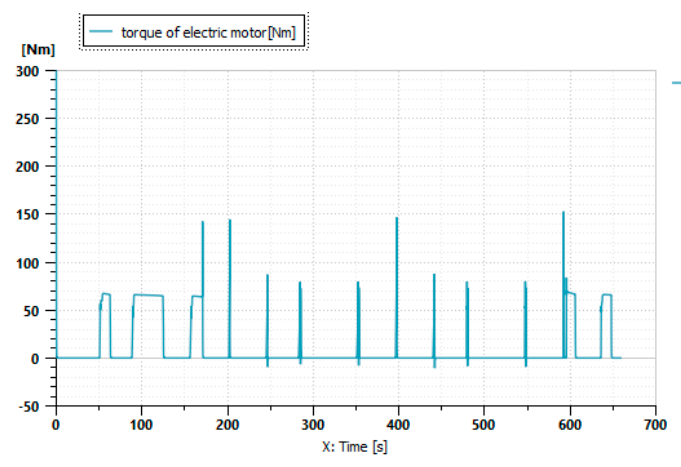
Figure 13. Electric motor torque.